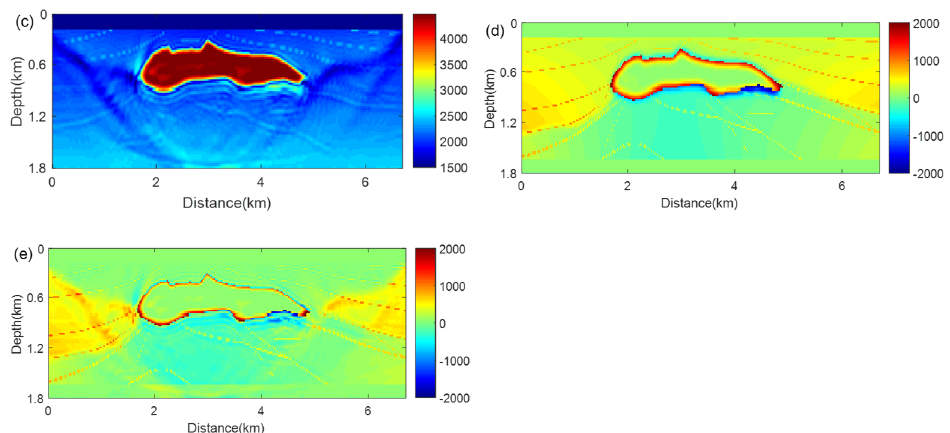
Figure 8. Inversion results by WDDEI and SGPD method. ( a ) RTM imaging result using Figure 7d as velocity model. ( b ) SGPD result. ( c ) Final inversion result of the proposed method. ( d ) Difference profile between Figures 4a and 8b. ( e ) Difference profile between Figures 4a and 8c.